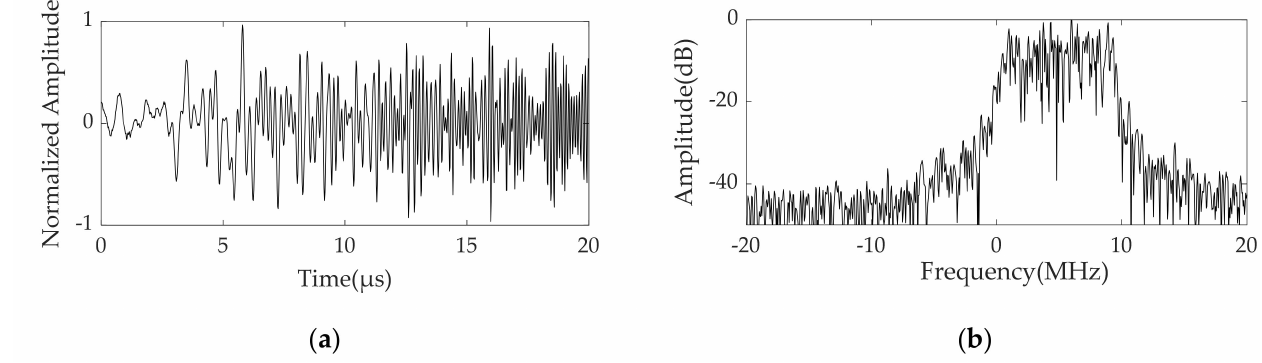
Figure 4. Time domain and frequency domain distribution of jamming signal. ( a ) Time domain; ( b ) frequency